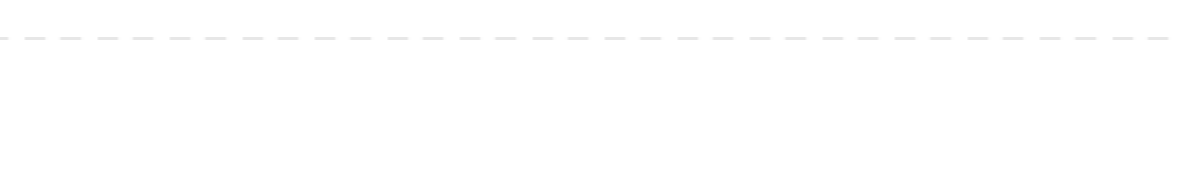
Figure S3: stages of development of the larvae are missing. Image C: in my